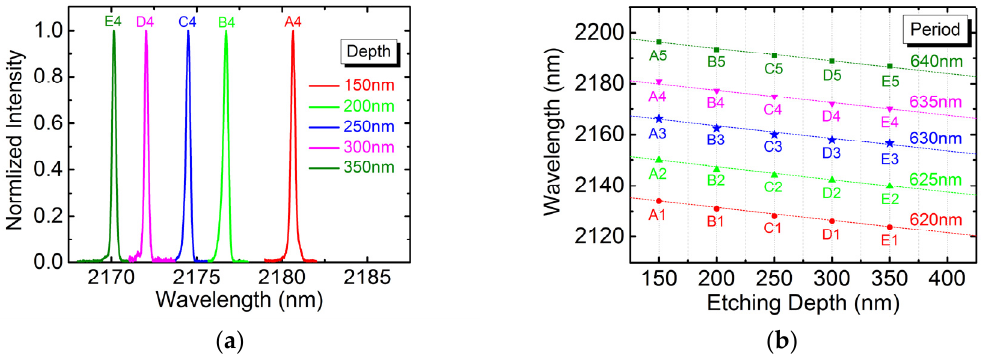
Figure 3. ( a ) The normalized lasing spectrum for devices with fixed lattice period of 635 nm. ( b ) The peak lasing wavelength versus etching depth for 25